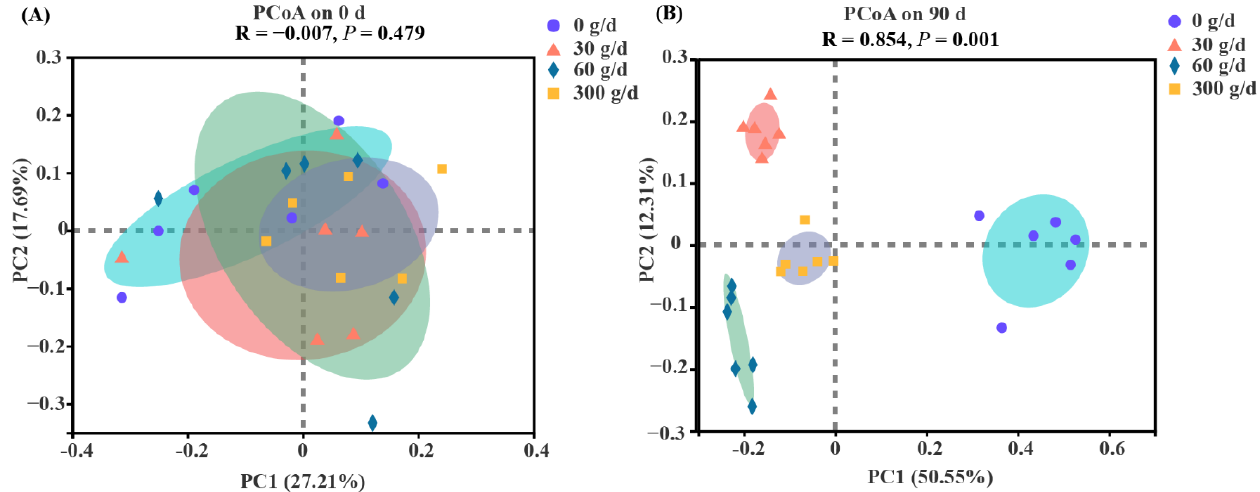
Figure 4. Bate diversity responses of the rumen microbiota to Acremonium terricola culture supple- mentation in lactating dairy cows on day 0 ( A ) and day 90 ( B ). Rumen microbiota of dairy cows fed a diet with supplementation of ATC at 0, 30, 60, or 300 g/d were used. Analysis of similarities (ANOSIM) using Bray–Curtis distance matrices was used to test the statistical differences. n = 6 .